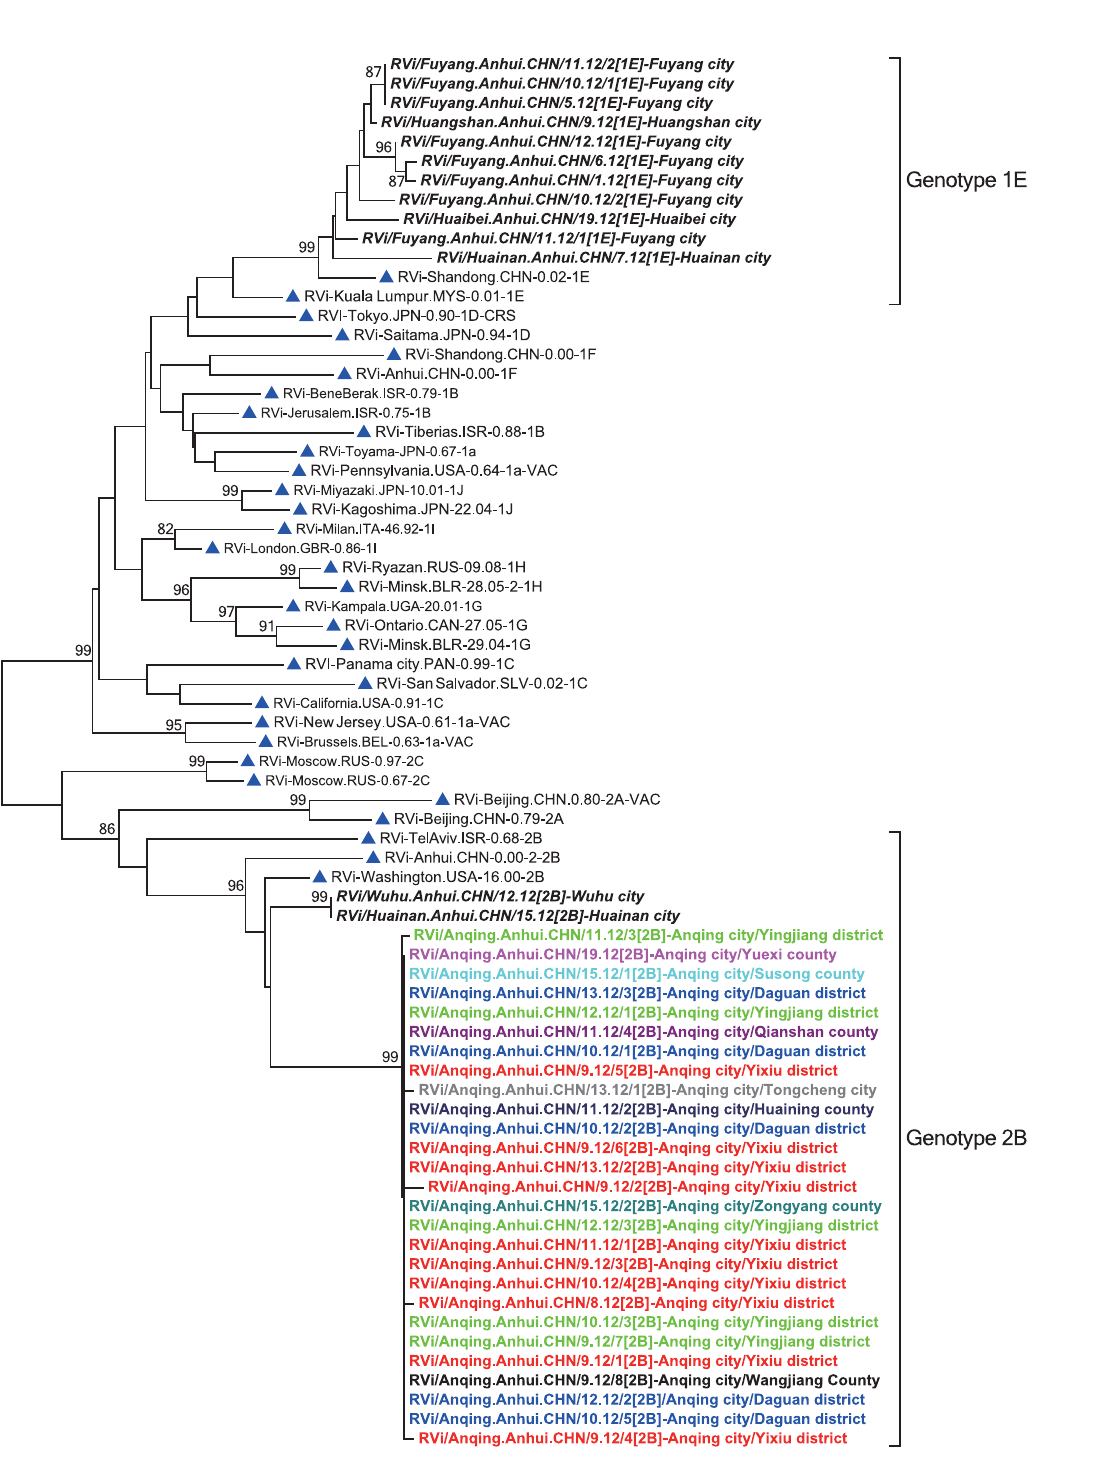
Fig 4. Phylogenetic analysis of 27 rubella virus (RV) sequences from the outbreak in Anqing city and 13 RVs from other cities in Anhui province in 2012, as well as the World Health Organization (WHO) reference sequences based on the WHO standard 739-nt window. The 32 WHO reference strains are indicated by blue triangles. The viruses from other cities are indicated by bold italic font. The viruses from 6 counties, 3 districts, and 1 county-level city of Anqing outbreak are indicated by different colors; and the first case of the outbreak is indicated by a red circle.